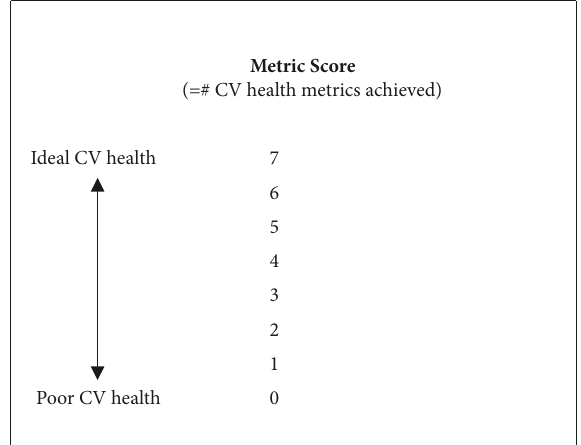
Figure 1: The concept of Ideal Cardiovascular Health with each point contributing to the total health score.